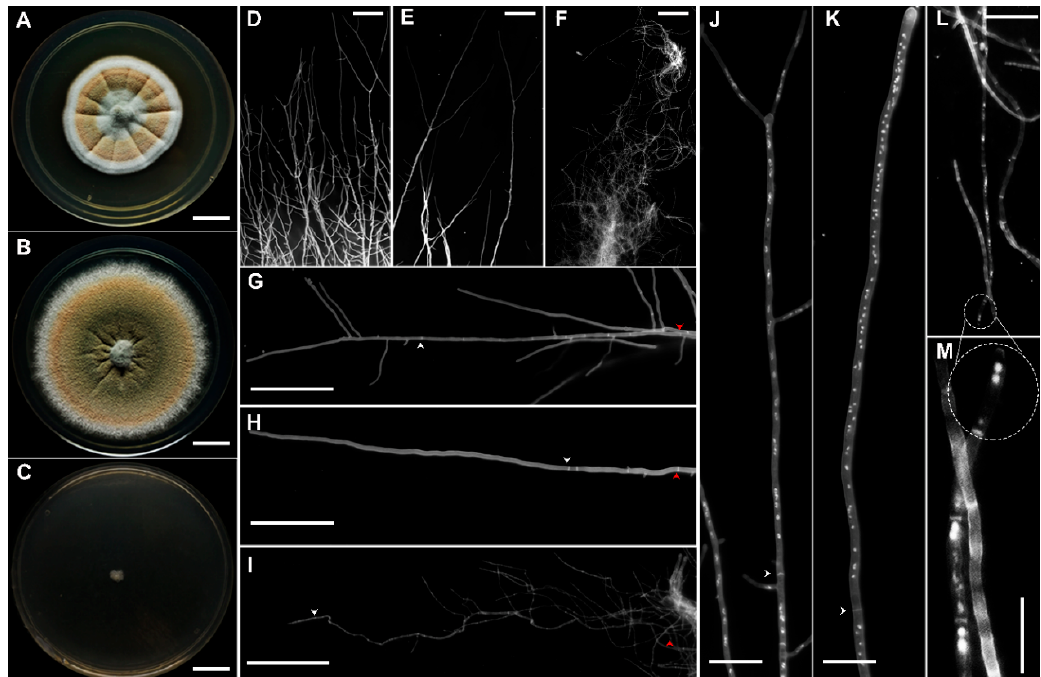
Figure 1. Morphological characterization of Aspergillus sydowii EXF-12860 grown on Yeast Malt Agar at different NaCl concentrations after 10 days of culture at 28 °C. ( A – C ) Colony appearance at 0, 1.0, and 5.13 M NaCl, respectively. Bars: 1 cm. ( D – F ) Stereoscopic examination of colonies contour after fungal growth at 0, 1.0, and 5.13 M NaCl, respectively. Bars: 100 µm. ( G – I ) Hyphae grown in the presence of 0, 1.0, and 5.13 M NaCl, respectively. Bars: 100 µm. White arrows indicate the first septum, while red arrows show 500 µm of length. Calcofluor white staining was applied in ( D – I ). ( J – L ) Multinucleation at 0, 1.0, and 5.13 M NaCl, respectively. Bars: 25 µm. ( L-M ) Small and large circles show the apical compartment of the hypha grown in 5.13 M NaCl. ( M ) A close-up of L. Bars: 25 µm. Staining using calcofluor white and DAPI was applied in ( J – M ).